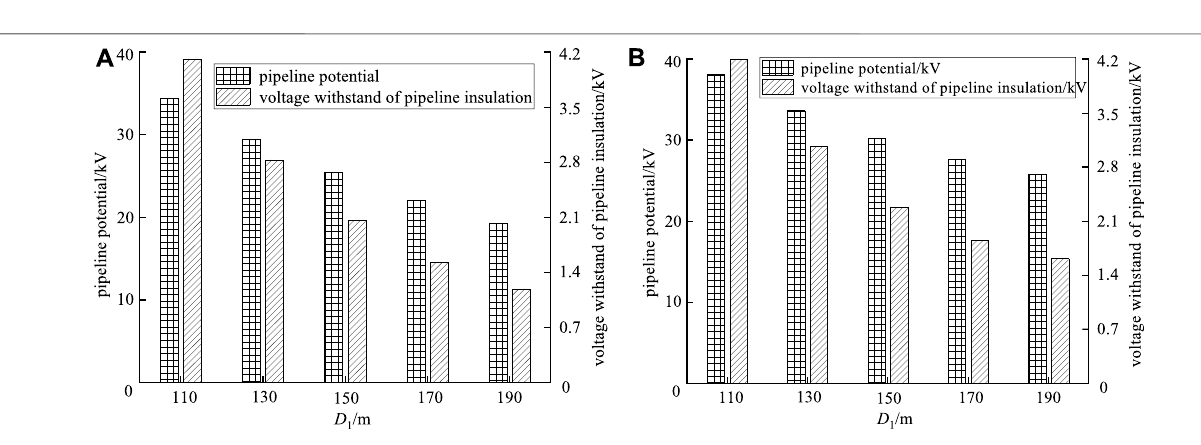
FIGURE5| In fl uenceof D 1 onpipelinepotentialandinsulatinglayervoltage. (A) showstheovervoltageofthegroundinggridoftheT 0 towertotheadjacentpipeline. (B) shows the overvoltage of the adjacent pipeline due to the common dispersion of the T 0 and T R1 tower grounding